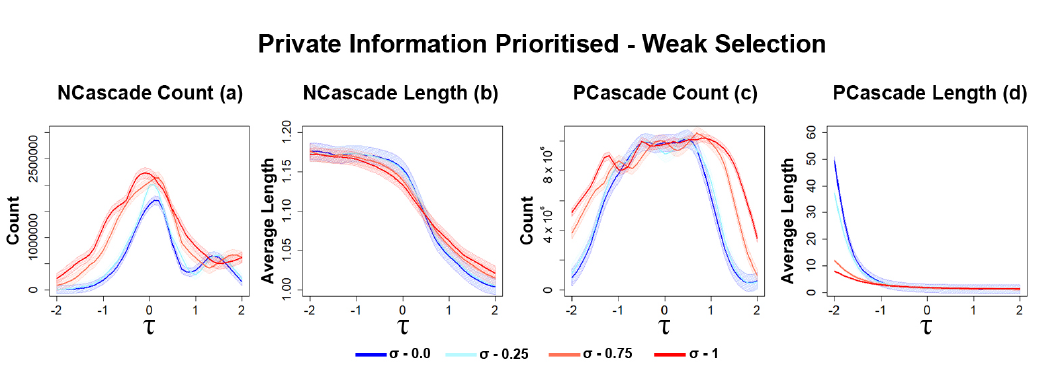
Figure 9. Increased opinion diversity generally leads to more, but shallower, information cascades when private information is prioritised. For both cascade types, each graph represents either the number or average length of each cascade type. Data obtained by running the model for 10 8 steps with p = 0.25 and q = 0.75 and a δ setting of 0.001. τ represents the decision threshold. σ represents opinion diversity. Shading represents level of standard error calculated for each dataset. Data interpolated utilising RStudio [22]. Plots produced via